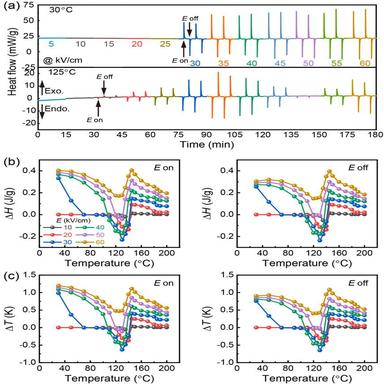
Direct EC measurement in PNZST AFE ceramic by modified DSC. (a) The isothermal heat flow curves as the electric field varies at 30 ◦C and 125 ◦C. The positive heat flow peaks indicate an exothermal phenomenon, whereas the negative peaks reflect an endothermal process. (b) The EC enthalpy changes ΔH and (c) temperature changes ΔT for the application and removal of electric field.